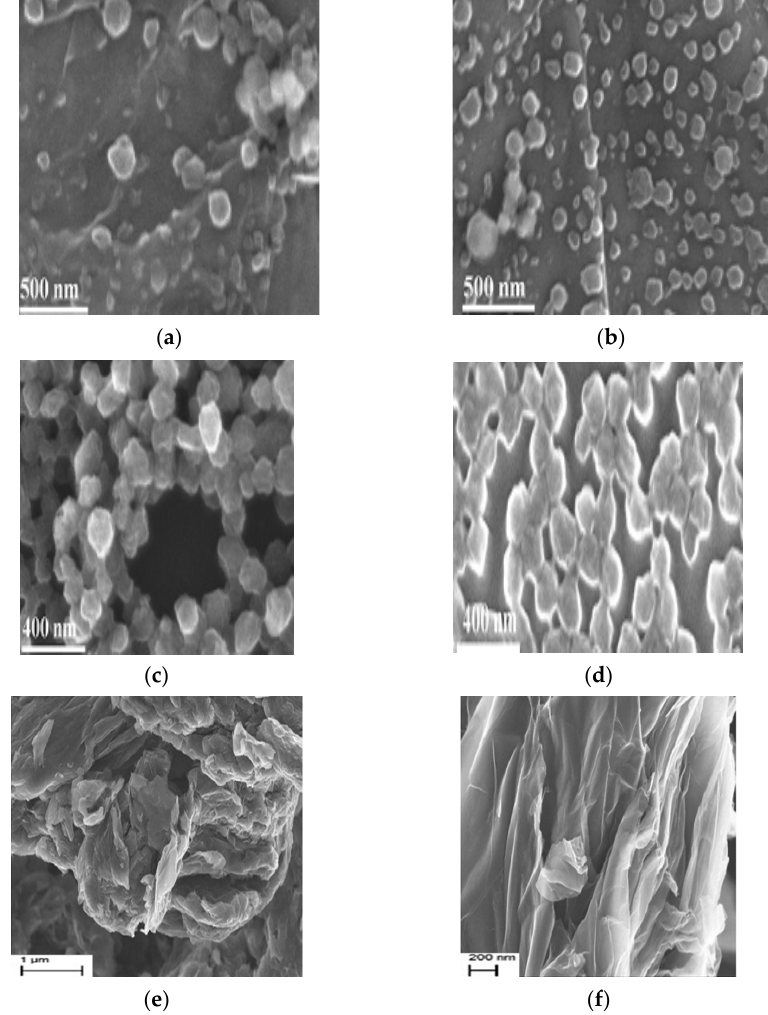
Figure 2. SEM image of ( a ) HPAN-PRGO; ( b ) PAN-PRGO; ( c ) HPAN; ( d ) PAN; ( e ) GO; and ( f ) GO-NH 2 .